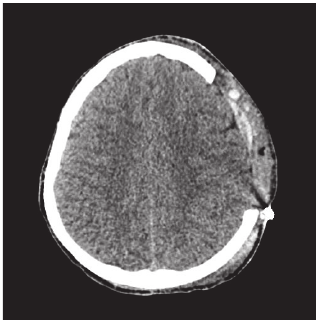
Figure 12. CT scan image of slice 170.